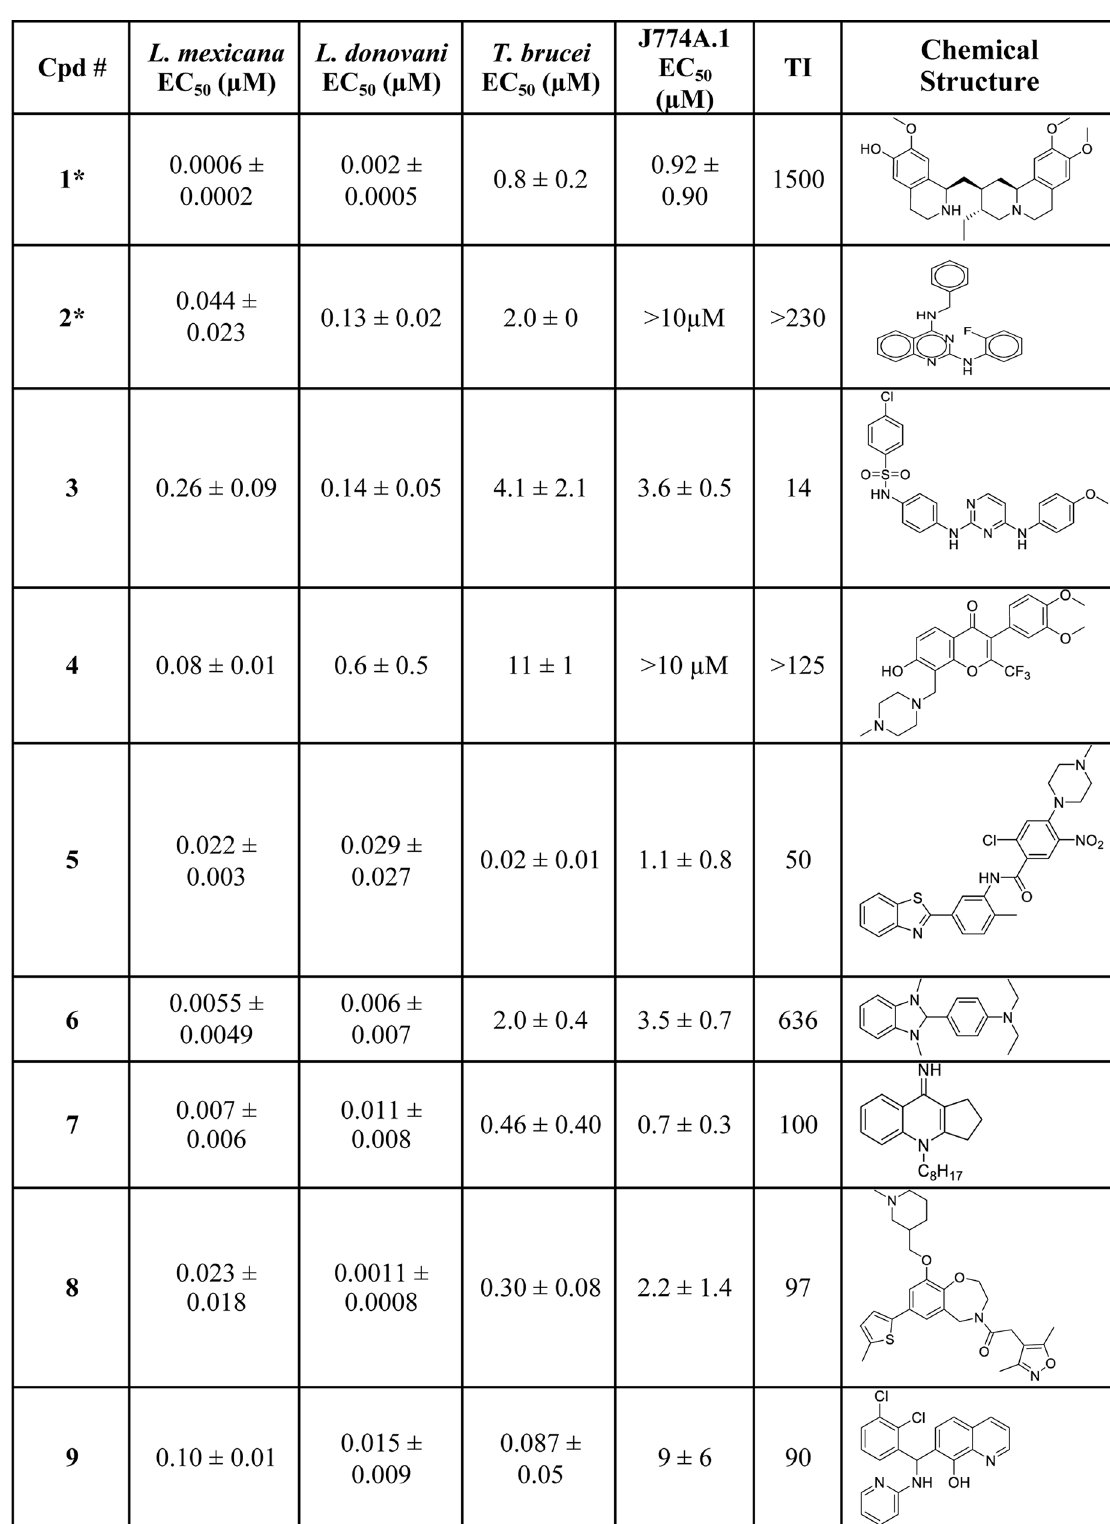
Fig 3. Top hits for inhibition of growth of L . mexicana amastigotes. EC 50 values represent the mean ± standarddeviation for n = 2 and were calculatedfrom dose-response curves against intracellular amastigotes of L . mexicana and L . donovani ,the